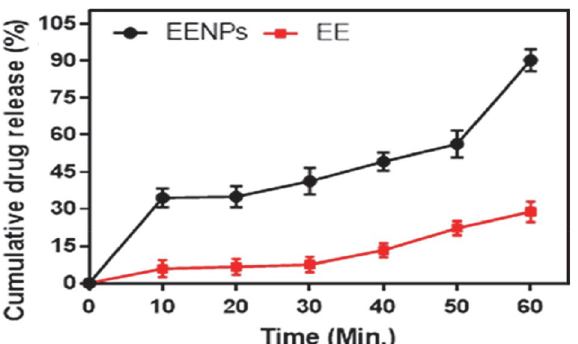
Figure 10. Dissolution profiles of optimized nanosuspension (EENPSs) with a pure drug in simulated gastric fluid.